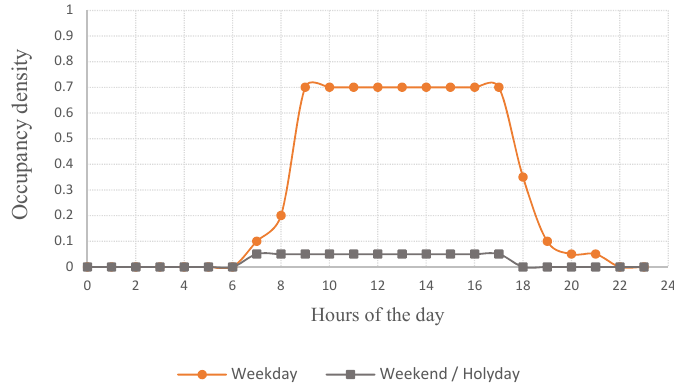
Figure 2. Occupancy schedule as defined by NABERS Handbook.